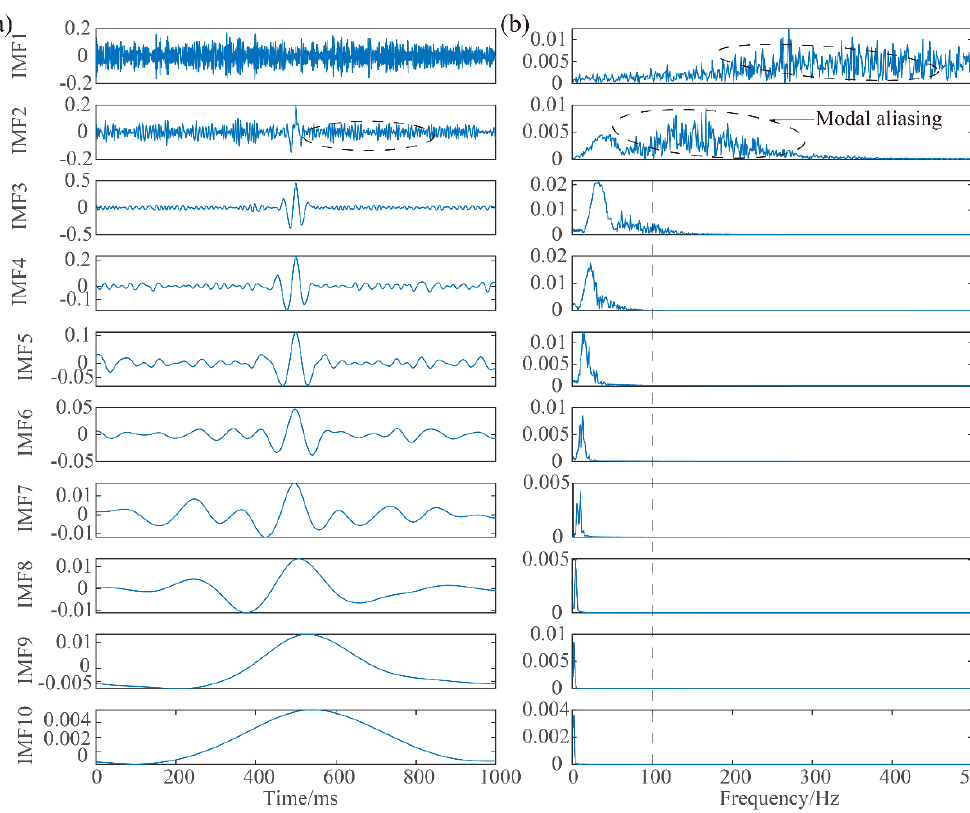
Figure 3. Waveforms and spectrums of a 25 Hz Ricker wavelet before and after adding white gaussian noise. ( a ) Noise-free wavelet waveform; ( b ) noise-free wavelet spectrum; ( c ) noisy wavelet waveform; ( d ) noisy wavelet spectrum.